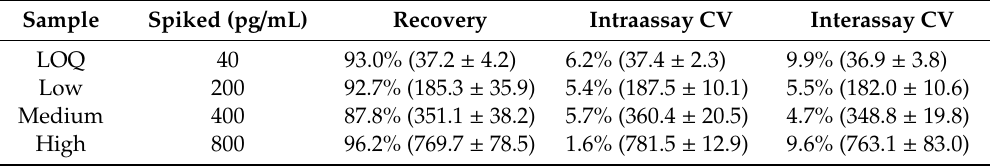
Figure 2. Representative chromatograms of standard solution and dog saliva sample. Blue line represent OT (1007.2 → 723.2 m / z ), red line represent OT-d 5 (1012.2 → 723.2 m / z ). OT standard solution contained 500 pg/mL OT. A 300 µL of OT standard solution or dog saliva was extracted with 1.2 mL 80% aqueous ACN containing 1000 pg/mL OT-d 5 . Table 1. Intra- and interassay CV 1 , and recovery of the present method for salivary OT.